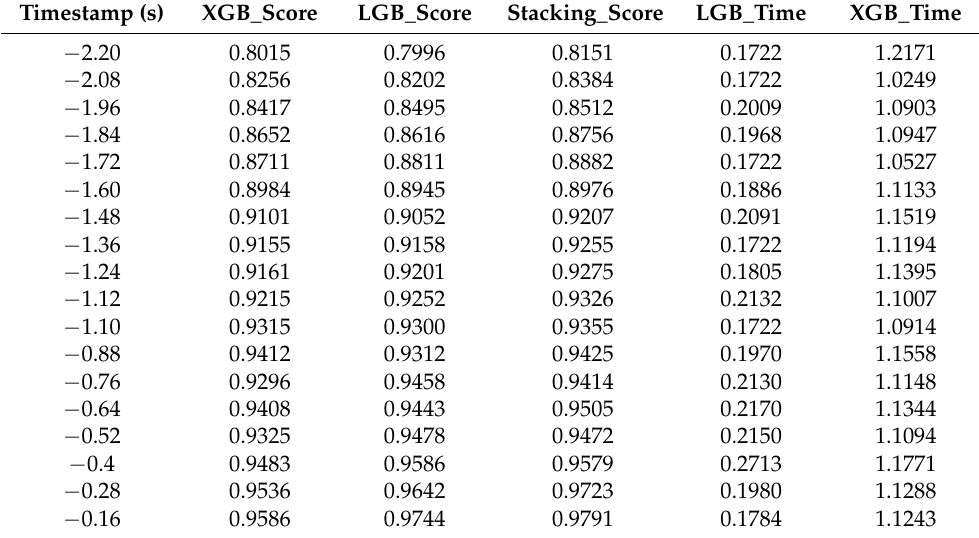
Table 10. Comparison of lane-changing intention recognition accuracy at different times.